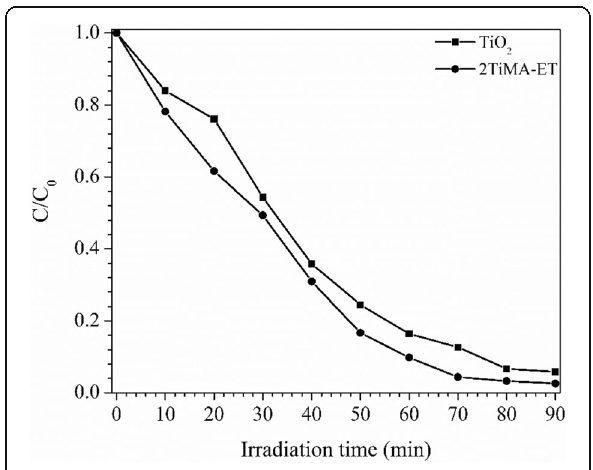
Fig. 12 The kinetics of MO (4 × 10 -5 M, pH = 7.0) photo- degradation using the catalysts: pristine TiO 2 and 2TiMA-ET